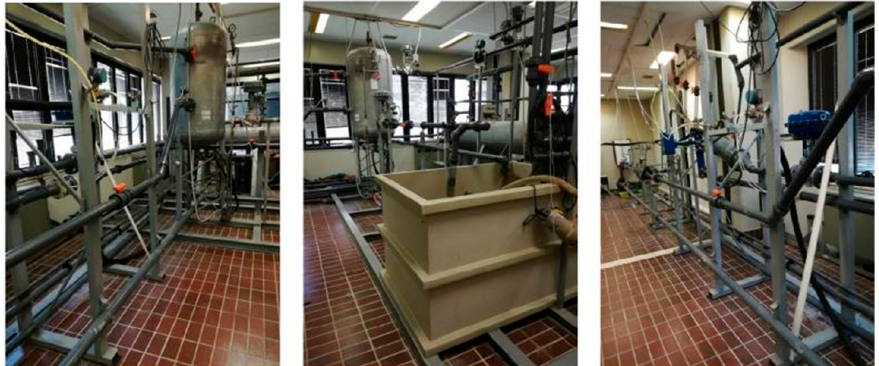
Figure 4. Some views of the experimental plant.